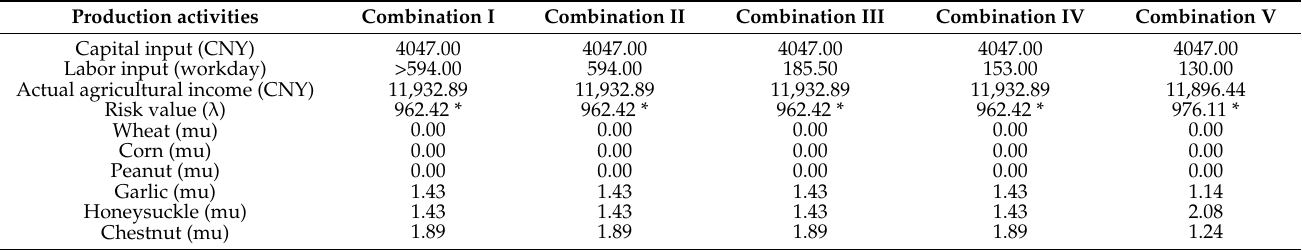
Table 11. Optimization of labor input for II PTPH